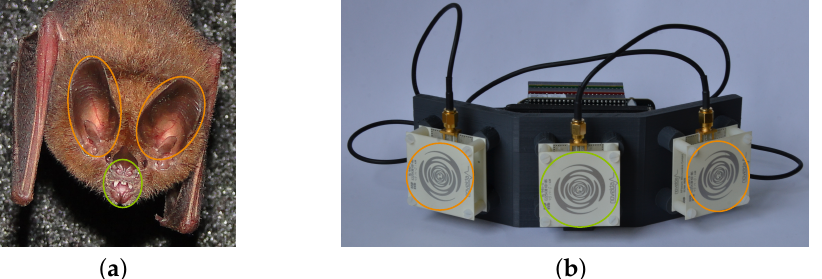
Figure 1. Comparison of the sensing mechanisms in biological echolocation and electronic echoloca- tion. In both images, the emitter is marked green, and the receivers are marked orange. ( a ) The com- mon big-eared bat ( Micronycteris microtis ). ( b ) A modified SensorLogic Ancho pulse-echo radar